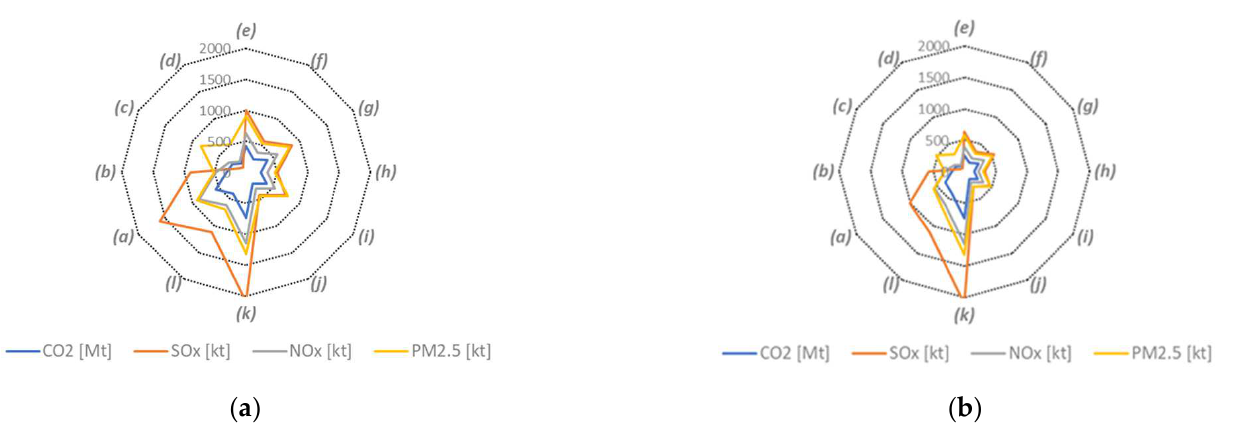
Figure 3. ( a ) Emissions of pure HVAC grid. ( b ) Emissions of hybrid HVAC-HVDC grid.